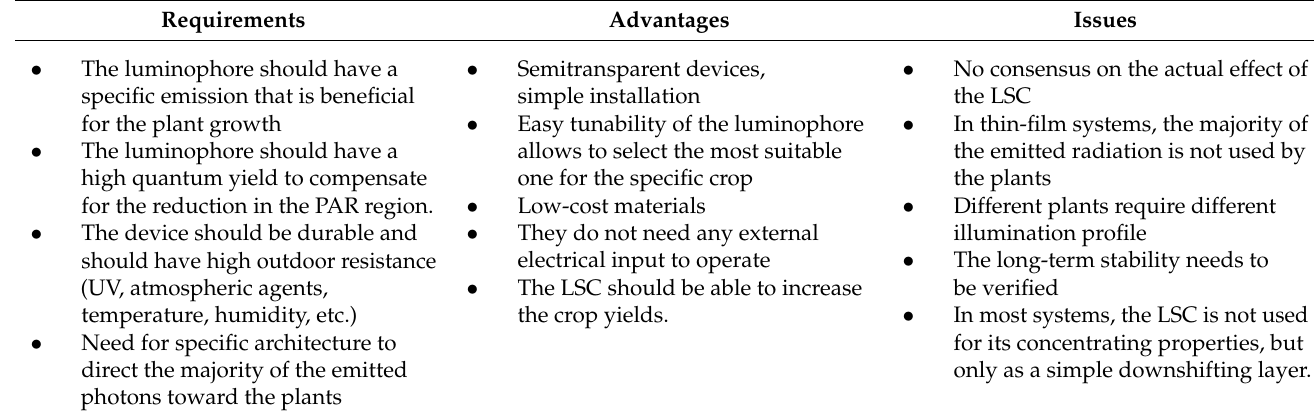
Table 2. Summary of the key parameters of LSC devices for CEA applications.